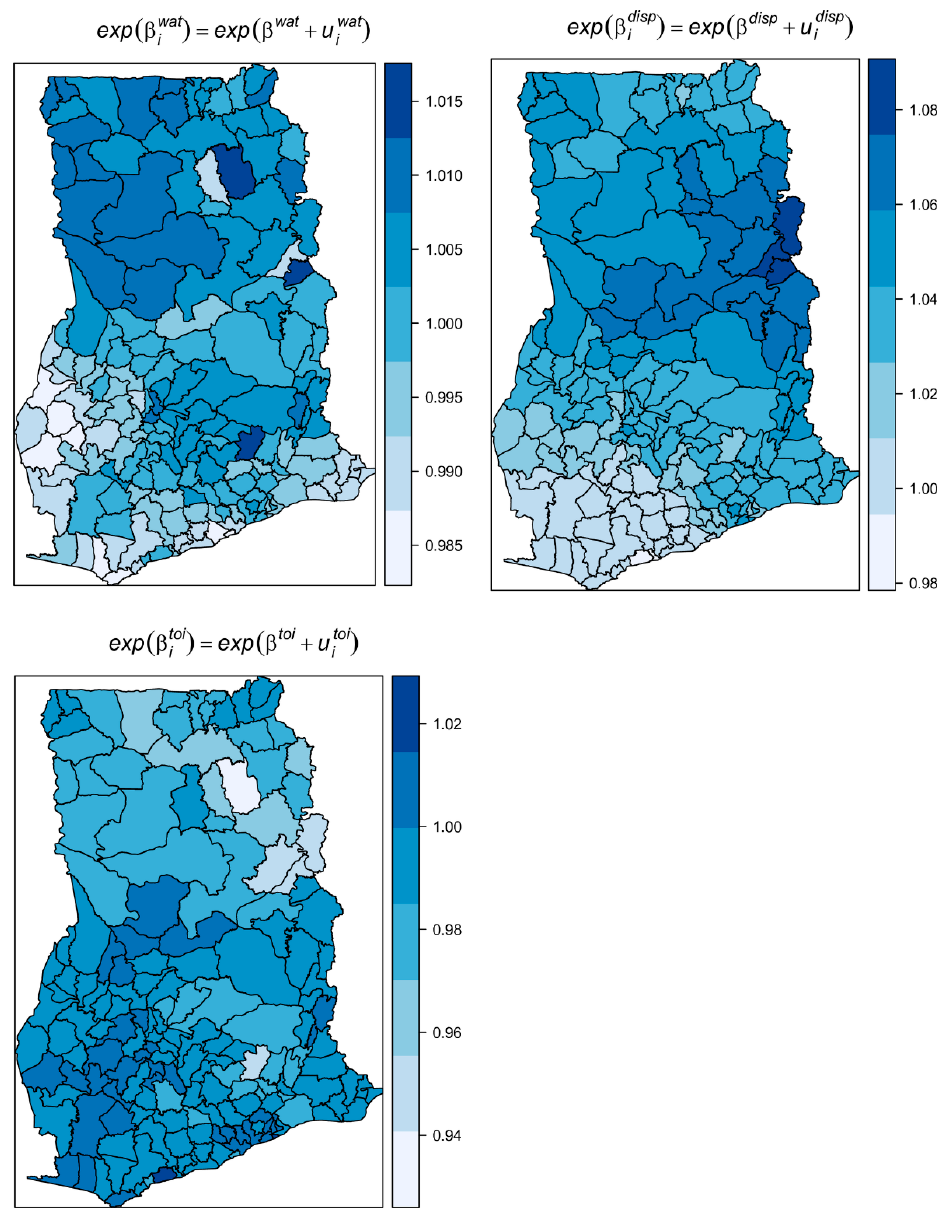
Figure 9. Maps of the spatially varying coefficients of unsafe water, unsafe toilets, and unsafe liquid waste disposal.